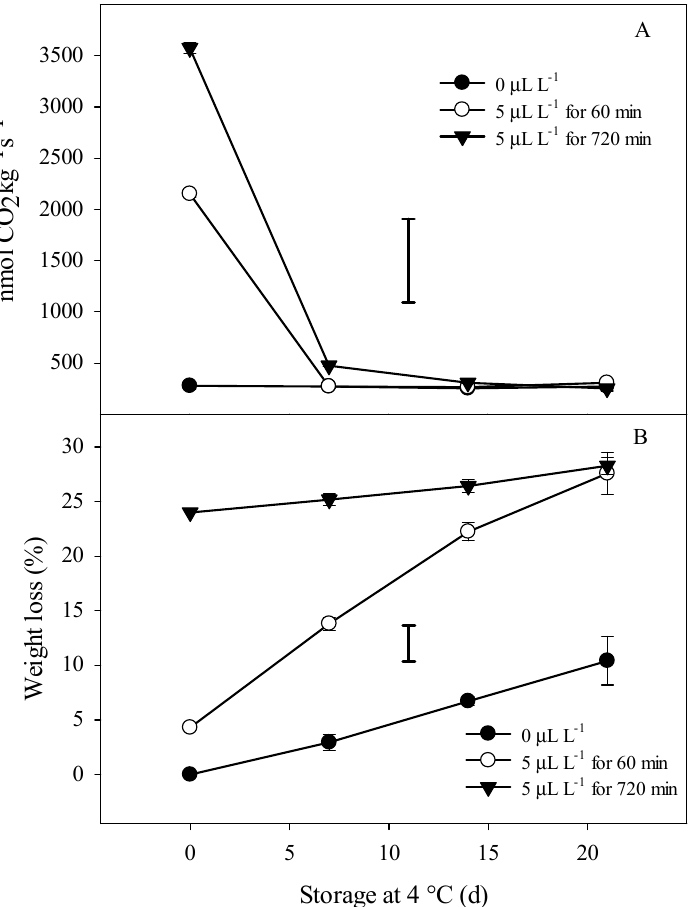
Figure 2. Progress of respiration rate and weight loss of O 3 -treated broccoli florets during storage of 21 d in the dark at 4 °C/90–95% RH. A: Production of carbon dioxide (CO 2 ) of florets treated with three ozone doses: ( ● ), control (0 µL L − 1 ); ( ○ ), hormetic dose (5 µL L − 1 for 60 min); and ( ▼ ), high (5 µL L − 1 for 60 min) dose. Each point is the mean of three repetitions, and vertical bars represent standard deviation. B: Weight loss of florets during storage. Bars are the means of nine repetitions with +SD. The bar in each graph represents the LSD value (0.05) = 813.3 ( A ) and 3.285 ( B ). d, day.